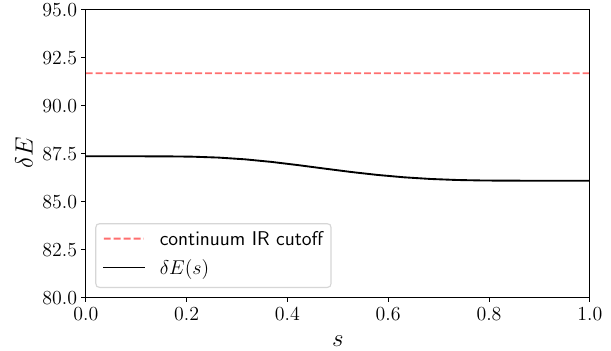
FIG. 12. The time-dependent energy gap for H ( s ) given by Eq. (22) (black solid line), where the two-particle Yukawa poten- tial in three dimensions Eq. (29) is used. The corresponding energy gap of the free-field system given by Eq. (25) (dotted red line) differs from the gap at H ( 0 ) with a correction of O ( a 2 ) at leading order, and is visible due to the relatively coarse lattice spacing used in this example.